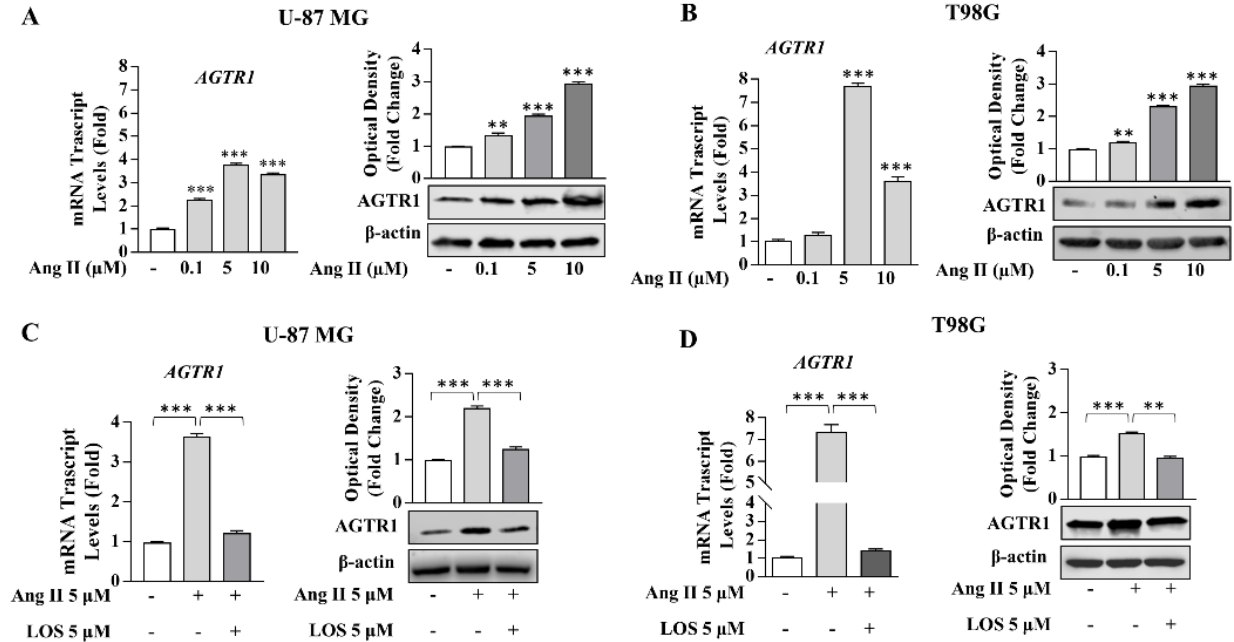
Figure 3. Effects of Ang II receptor antagonist Losartan on Ang II-induced AGTR1 expression in U-87 MG and T98G glioblastoma cells. ( A , B ) Real-time RT-PCR and immunoblotting assay for AGTR1 mRNA and protein expression in U-87 MG and T98G cells treated with vehicle ( − ) or the Ang II 0.1, 5, and 10 µ M for 24 h. β -actin was used as a loading control. The histograms represent the mean average ± SD of three separate experiments in which band intensities were evaluated in terms of optical density arbitrary unit and expressed as fold change over vehicle ( − ) for Ang II treatment. ( C , D ) AGTR1 mRNA and protein expression in U-87 MG and T98G cells treated with vehicle ( − ) and Ang II 5 µ M alone or in combination with LOS 5 µ M for 24 h. The histograms represent the mean average ± SD of three separate experiments in which band intensities were evaluated in terms of optical density arbitrary unit and expressed as fold change over vehicle ( − ) for Ang II treatment or fold over Ang II for Ang II in combination with LOS. β -actin was used as a loading control. Data represent the mean ± SD of three different experiments, each performed in triplicate. ** p < 0.01; *** p < 0.001.